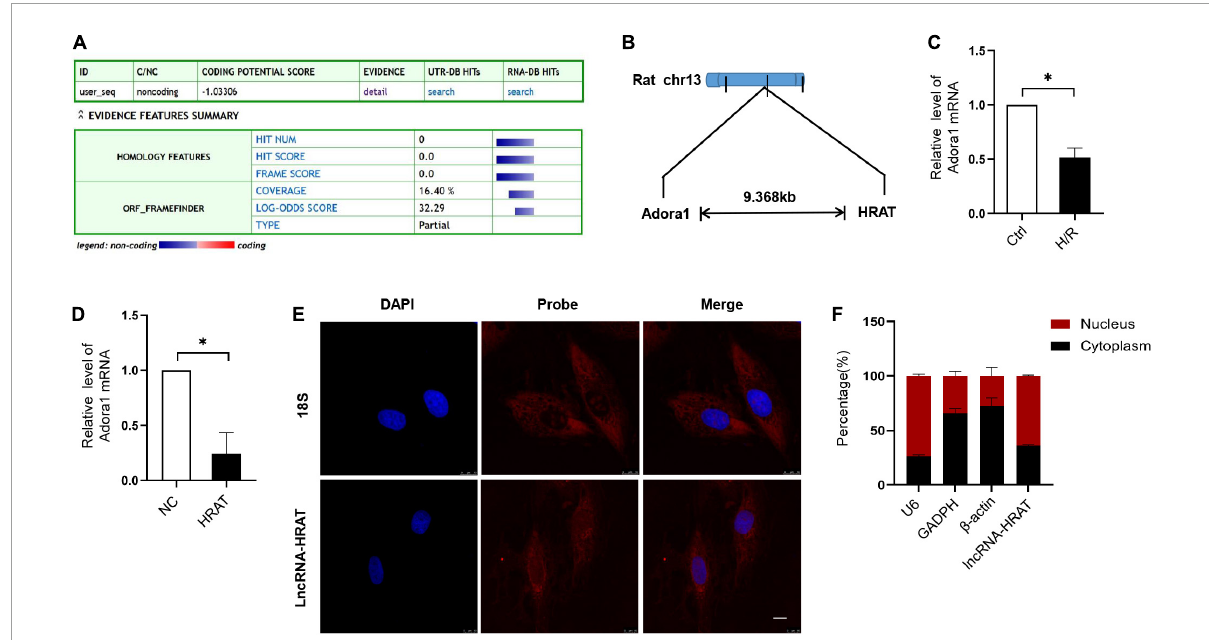
FIGURE3 Characterization of lncRNA-HRAT. (A) Assessment the protein-coding potential of lncRNA-HRAT by Coding Potential Calculator Online. (B) Schematic annotation of the lncRNA-HRAT genomic locus. (C) The analysis of Adora1 expression in Ctrl and H/R cells was conducted through qRT-PCR ( n = 3). (D) The analysis of Adora1 expression in H9c2 cells infected with lncRNA-HRAT or control lentivirus was conducted through qRT-PCR ( n = 3). (E) The localization of lncRNA-HRAT in H9c2 cells was tested via RNA FISH ( n = 3). Nuclei was stained with 40,6-diamidino-2-phenylindole (DAPI; blue), 18S and lncRNA-HRAT appeared red. Scale bar, 10 µ m. (F) The analysis of lncRNA-HRAT expression in the nucleus and cytoplasm of H9c2 cells was employed through qRT-PCR ( n = 3). The cytoplasmic control was GAPDH and β -actin, while the nuclear control was U6. All the data are described as the mean ± SD. * P <